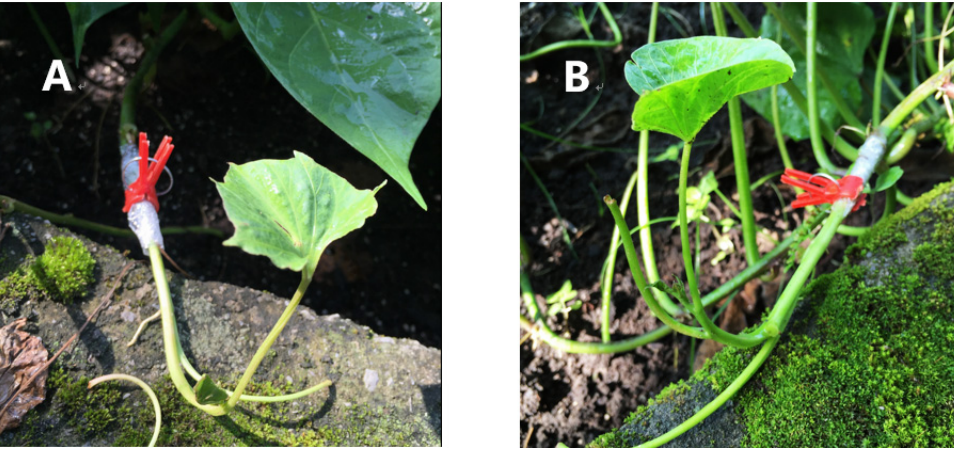
Figure 5. Insertion grafting and side grafting methods. ( A ) The effect of the insertion grafting method after grafting. ( B ) The effect of the side grafting method after grafting.